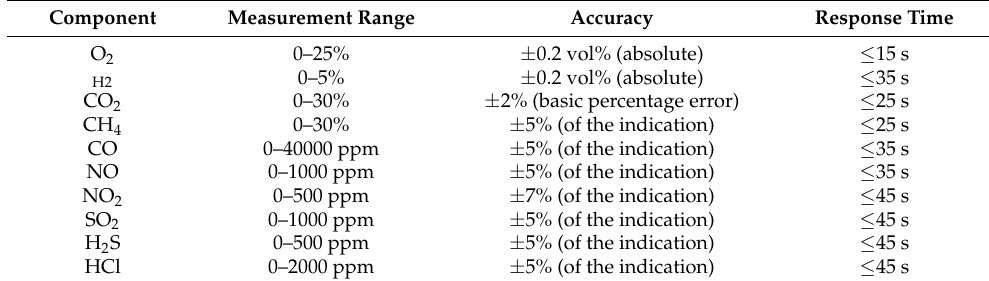
Table 3. Specifications of the gas